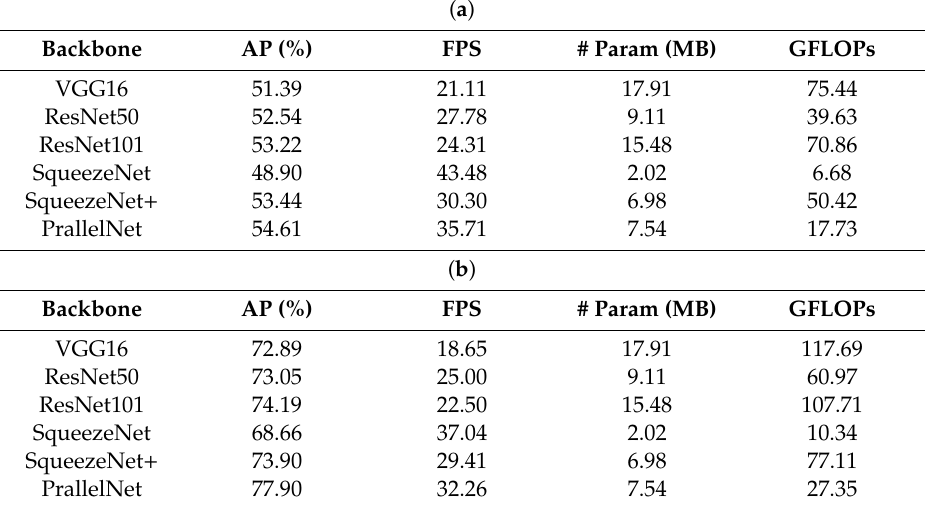
Table 2. Comparison results of ParallelNet with some most commonly used backbone evaluated on Caltech–Zhang and KITTI dataset. AP is the average precise, which is used to measure the detection accuracy; FPS is the number of images processed per second, which represents the detection speed; # Param is the number of model elements, the lower is better; GFLOPs is the FLOPs (floating point of operations) per image, which also the lower is better. ( a ) On Caltech–Zhang; ( b ) On